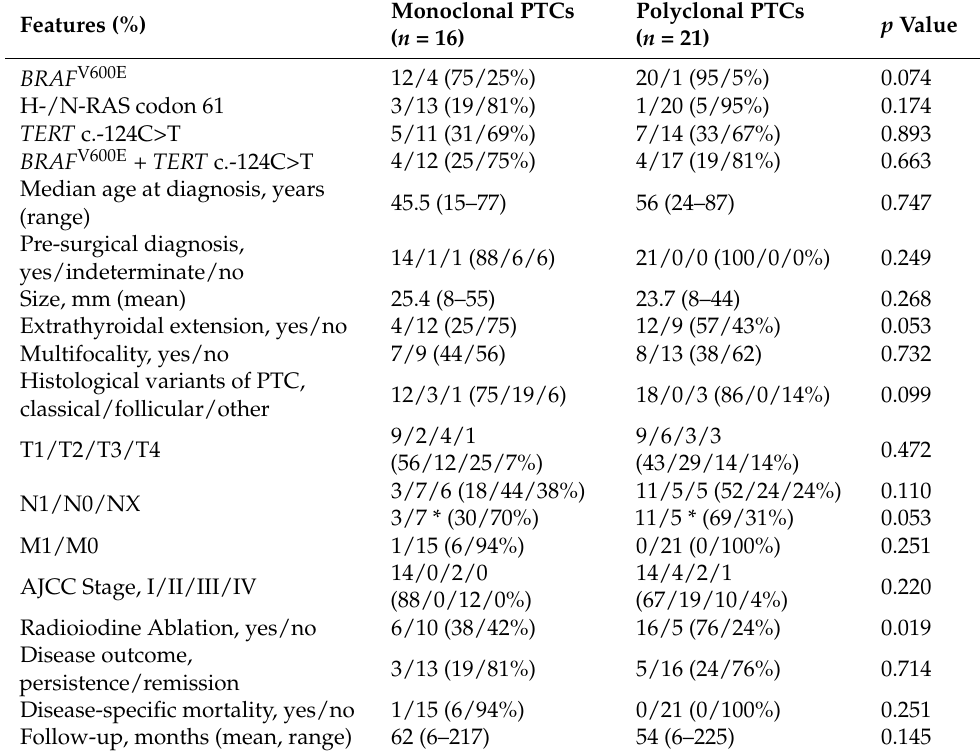
Table 2. Comparison of molecular and clinico-pathological features of the 16 monoclonal and the 21 polyclonal PTCs analyzed. PTC, papillary thyroid carcinoma; TNM, tumor, node, metastasis; AJCC, American Joint Committee on Cancer. * excluding the NX